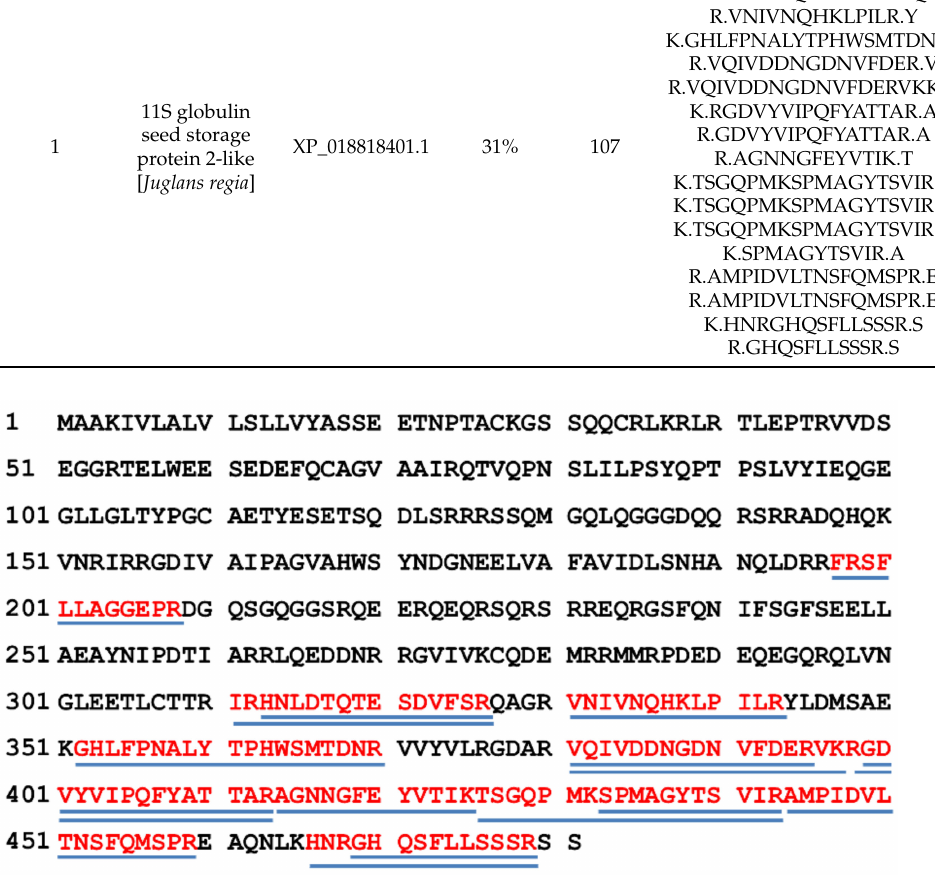
Figure 4. Alignment of peptides identified by MALDI-TOF/TOF tandem mass spectrometry and the MASCOT Database Search engine in the 11S globulin seed storage protein 2-like ( Juglans regia ) (Accession Number: